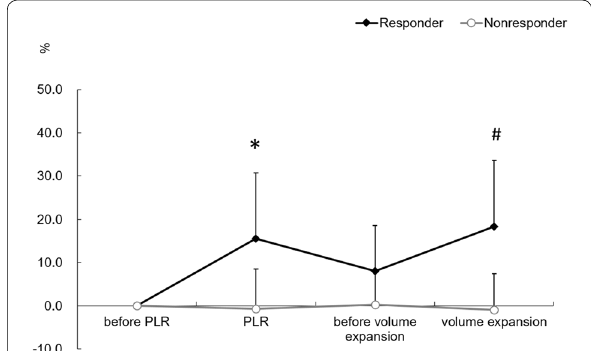
Fig. 2 Changes in transcutaneous partial pressure of oxygen before and during a PLR and then before and after volume expansion. PLR, passive leg raising. PtcO 2 , transcutaneous partial pressure of oxygen. * p < 0.05 versus before PLR, # p < 0.05 versus before volume expansion